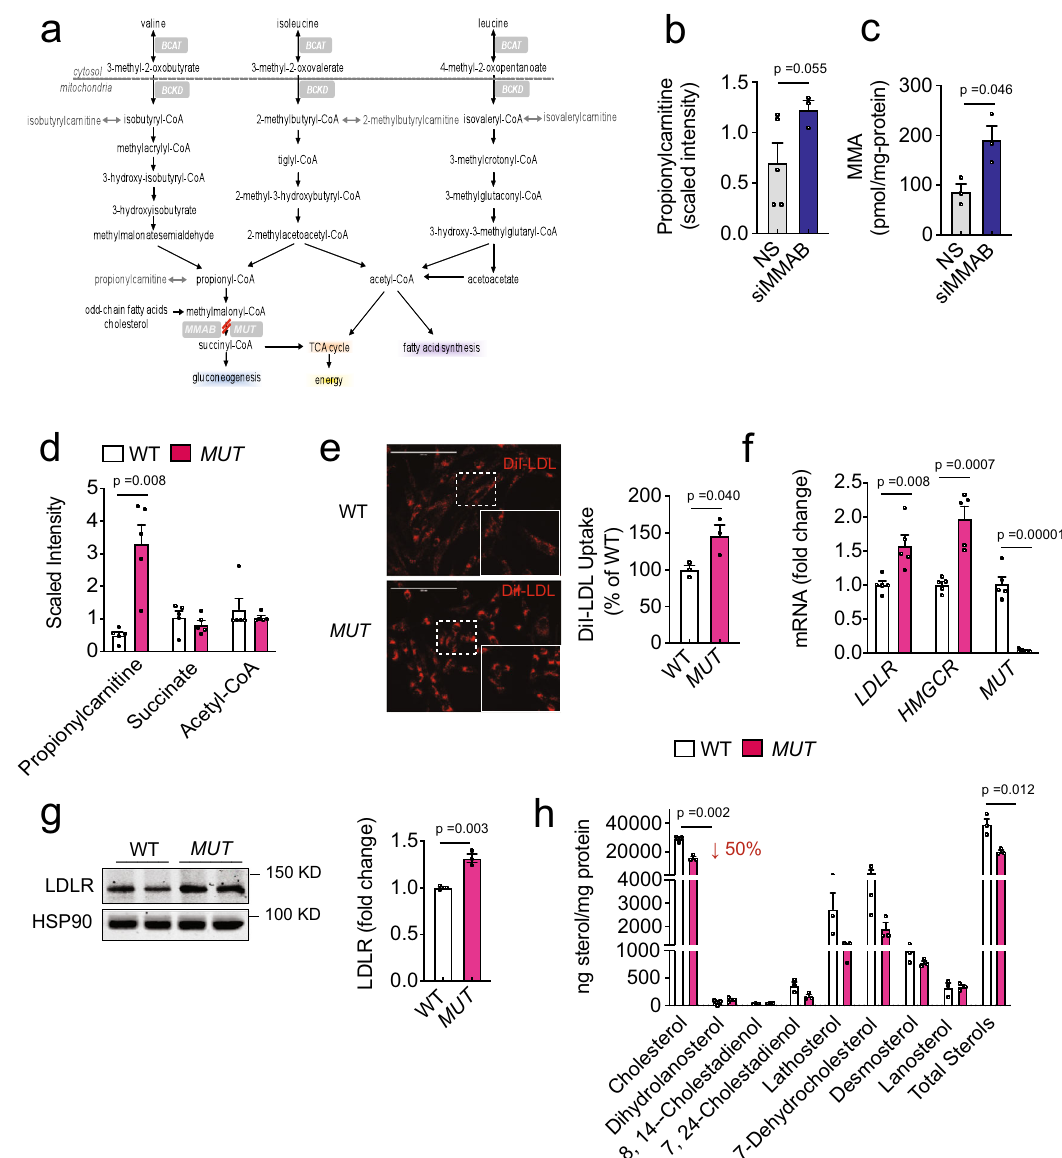
Fig. 5 MUT -de fi cient human fi broblasts have increased LDLR expression and function and decreased sterol content. a Catabolism of odd-chain fatty acids, cholesterol, and amino acids. MMAB catalyzes the fi nal step in the conversion of vitamin B 12 into adenosylcobalamin (AdoCbl), a coenzyme for methylmalonyl-coA mutase ( MUT ). Mutations in MMAB or MUT lead to the metabolic disorder, methylmalonic aciduria. b , c Propionylcarntitine ( b ) and methylmalonic acid (MMA) ( c ) content in Huh7 cells transfected with a non-silencing siRNA (NS) or siRNA MMAB (siMMAB) for 60 h. Data are mean ± s.e.m. n = 3 – 5 biological replicates per group. Statistical comparisons by unpaired Welch ’ s two-sample t test. d Relative levels of propionylcarnitine, succinate and acetyl-CoA in WT and MUT- de fi cient fi broblasts incubated in DMEM containing 10% LPDS for 24 h. Data are mean ± s.e.m. of fi ve independent experiments. Statistical comparisons by unpaired Welch ’ s two-sample t test. e Representative images of DiI-LDL uptake in human fi broblasts de fi cient of methylmalonyl-coA mutase ( MUT ) or wild-type (WT) controls and incubated with 30 μ g/ml DiI-LDL for 2 h at 37 °C. Red, DiI-LDL. Scale, 200 μ m. Quanti fi cation of DiI-LDL uptake by FACS is shown to the right. Data are mean ± s.e.m. of three independent experiments. Statistical comparisons by unpaired two-sided Student ’ s t test. f , g qRT-PCR ( f ) and Western blot ( g ) analysis of SREBP2 responsive genes in WT and MUT fi broblasts incubated in LPDS for 24 h. HSP90 was used as a loading control. Quanti fi cation of blot is shown to the right. Data are mean ± s.e.m. of 3 – 5 independent experiments in duplicate, respectively. Statistical comparisons by unpaired two-sided Student ’ s t test. h Sterol content of WT and MUT fi broblasts incubated in DMEM containing 10% LPDS for 24 h. Lipids were extracted and analyzed by GC-MS. “ Total sterols ” were calculated as the sum of all sterols that could be detected. Data are mean ± s.e.m. of three independent experiments. Statistical comparisons by unpaired two-sided Student ’ s t test. Source data are provided as a Source Data fi